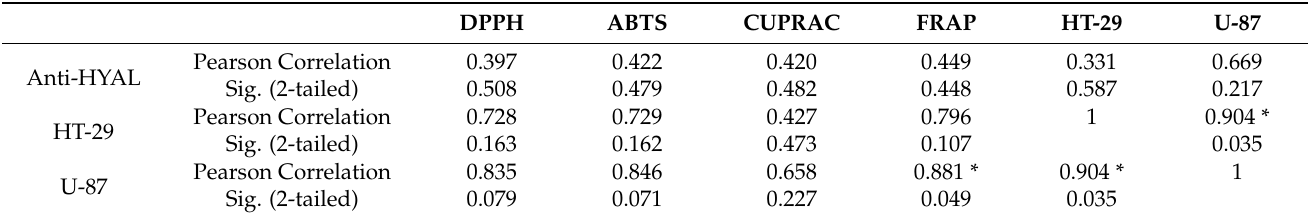
Table 2. Correlation among antioxidant, anti-hyaluronidase, and anti-proliferative activity in apple